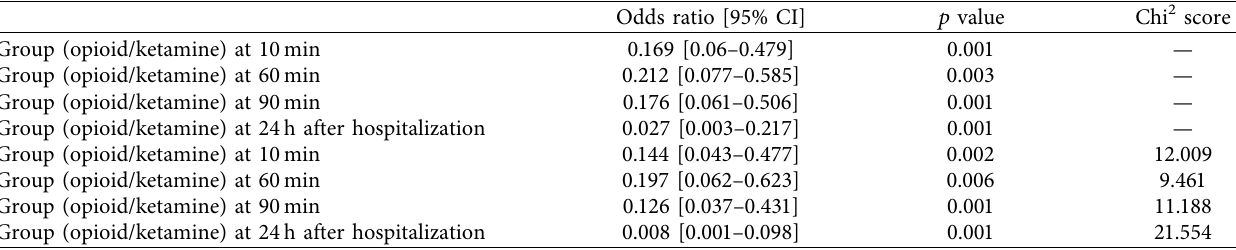
Odds ratio [95% CI]